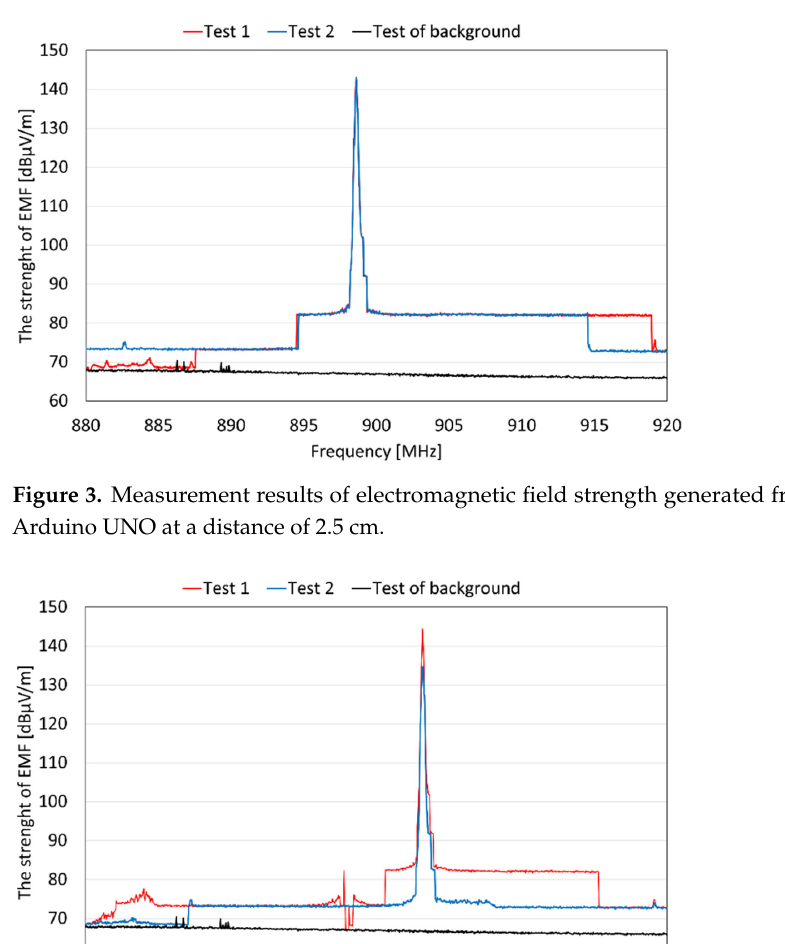
Figure 2. Measurement results of electromagnetic field strength generated from a device built on Arduino UNO at a distance of 0 cm.